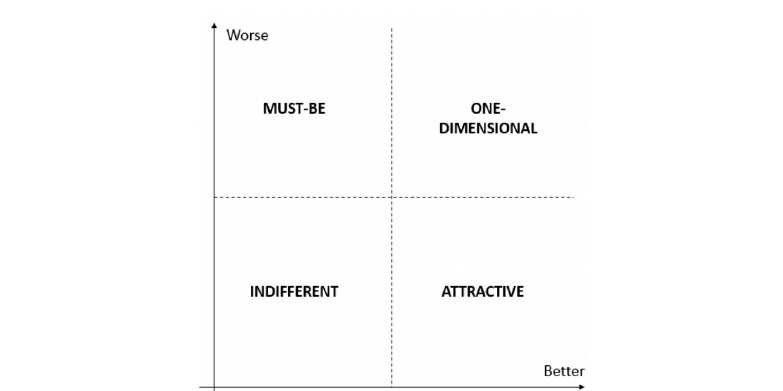
Variation Coefficient